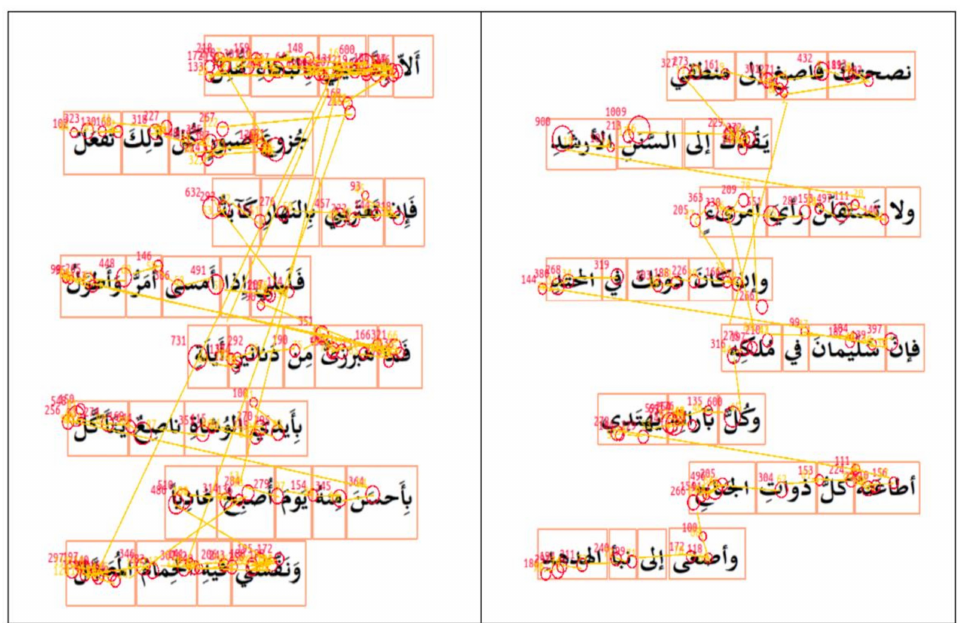
Figure 2. Examples of the eye-tracker output from two texts that show fixations and saccades of one of the participants when reading the two texts. The text on the right is a poem written in the Andalusian era with a higher readability score than the text on the left, which is a poem written in the pre-Islamic era. Orange boxes represent interest areas, the red circles represent the fixations, the numbers above these fixations represent their durations, and the yellow arrows represent the saccades.